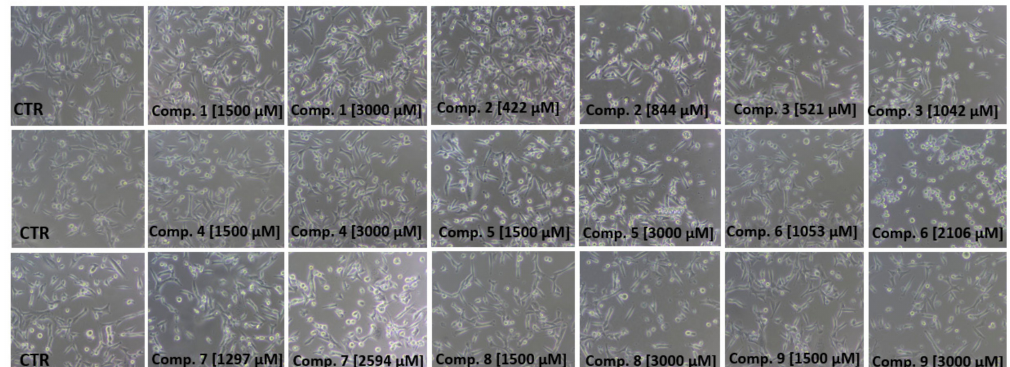
Figure 6. Dose-dependent e ff ects of sulfonamide derivatives of metformin (compounds 1 – 9 ) on MDA-MB-231 cells’ viability and morphology after 24 h of incubation. Compounds 2 , 3 , 6 and 7 × IC µ mol / L) values. Compounds were used at concentrations corresponding to their 1 50 and IC 50 ( 2 1 , 4 , 5 , 8 and 9 decreased the viability of MDA-MB-231 cells to approximately 60%. Their e ff ects on MDA-MB-231 cells’ morphology were evaluated using the concentrations of 1500 and 3000 µ mol / L. Representative cell images are shown (100-fold magnification);